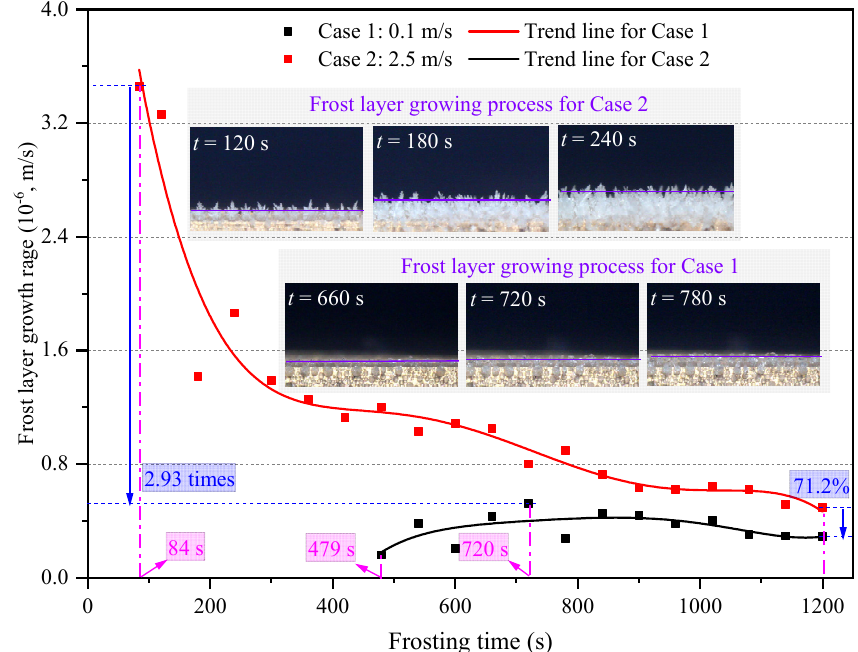
Figure 13. Frost layer growth rate in the edge-affected region.